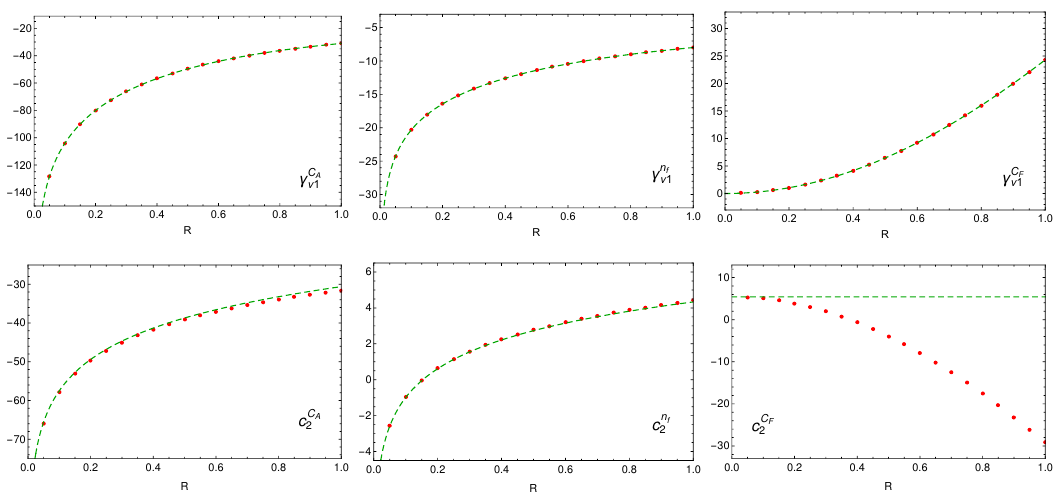
Figure 4. Two-loop rapidity anomalous dimension and (cid:12)nite term of the RRG renormalised p T veto soft function. Red dots indicate values calculated with SoftSERVE and green dashed lines show the interpolating functions from [17] (upper plots) and [18] (lower